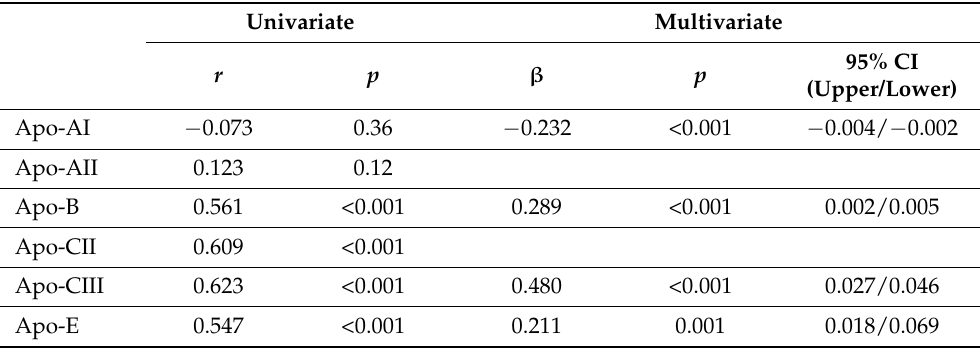
95% CI (Upper/Lower)